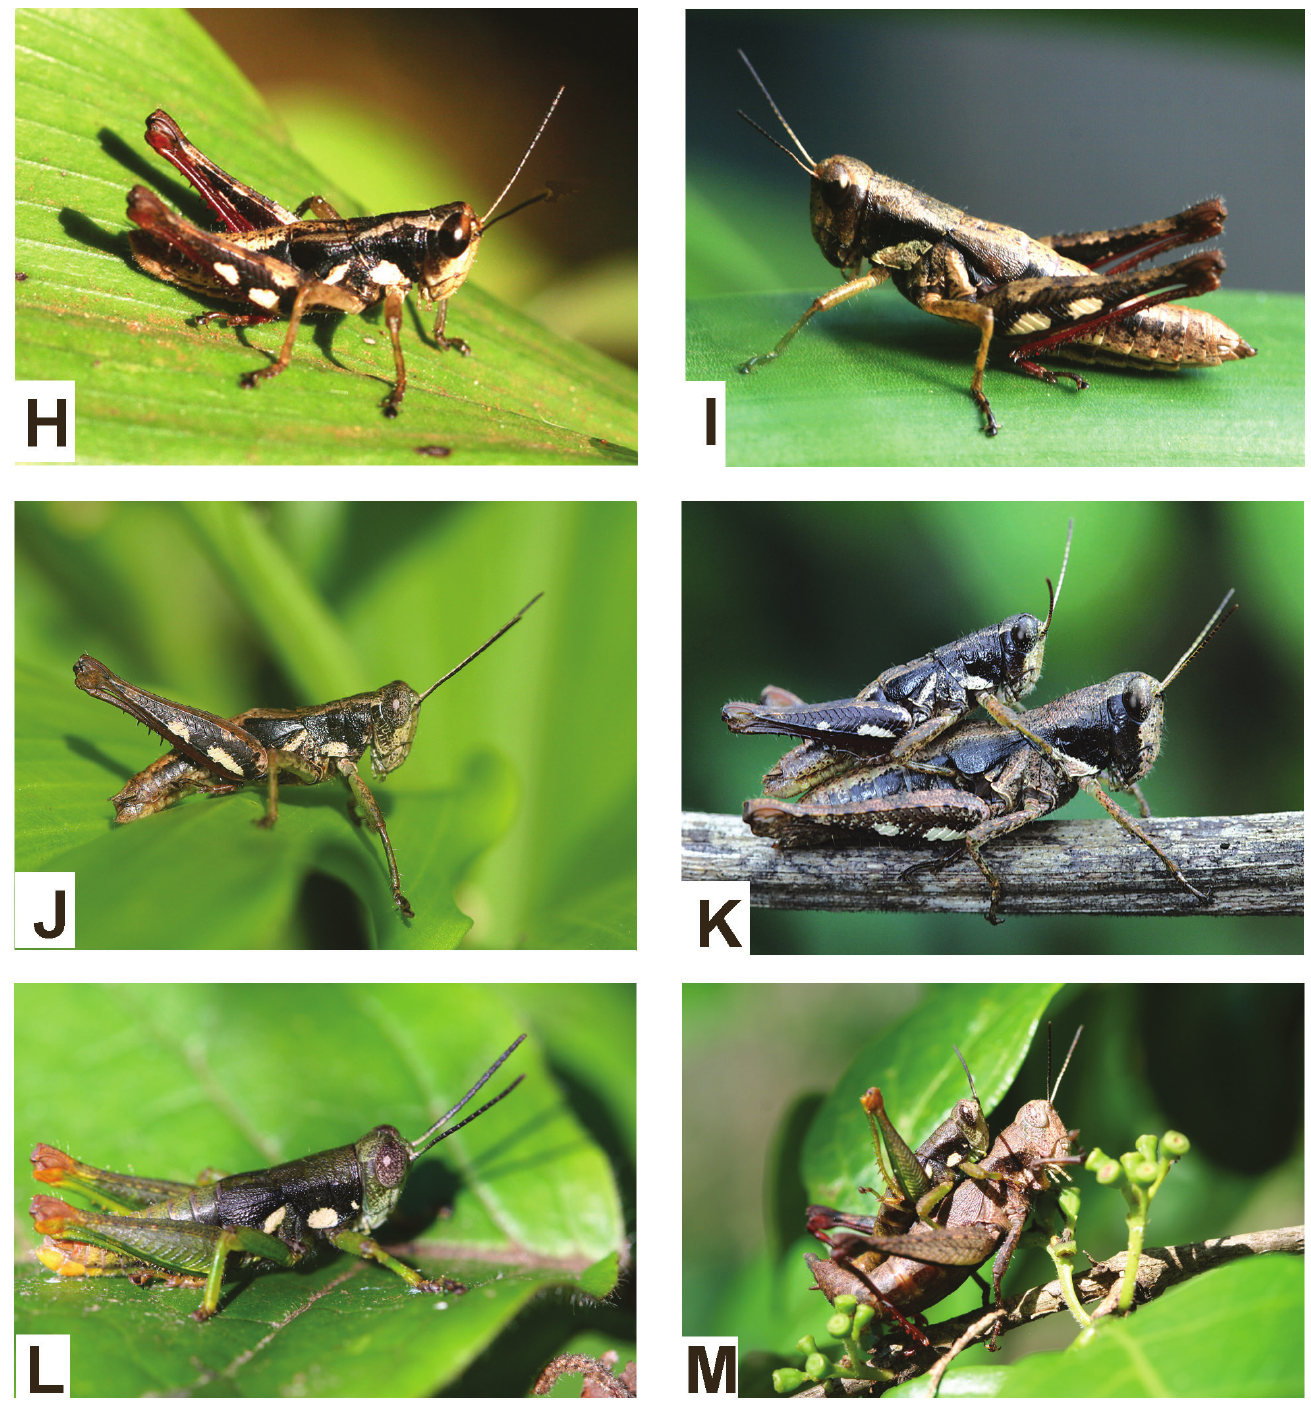
Fig. 2. H–I. Aresceutica morogorica : H. Male, alive; I. Female, alive; J–K. Aresceutica subnuda : J. Male alive; K. Male and female, in cop., alive; L–M. Duviardia vansomereni : L. Male alive; M. Male and female, in cop.,